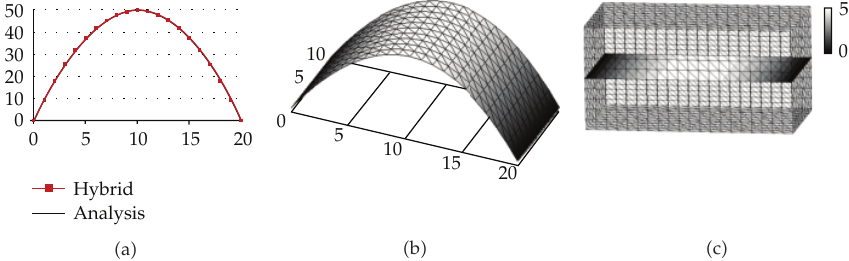
Figure 4: The results of the hybrid method. (cid:2) a (cid:3) , (cid:2) b (cid:3) , and (cid:2) c (cid:3) are the results of Figures 3 (cid:2) a (cid:3) , 3 (cid:2) b (cid:3) , and 3 (cid:2) c (cid:3) ,